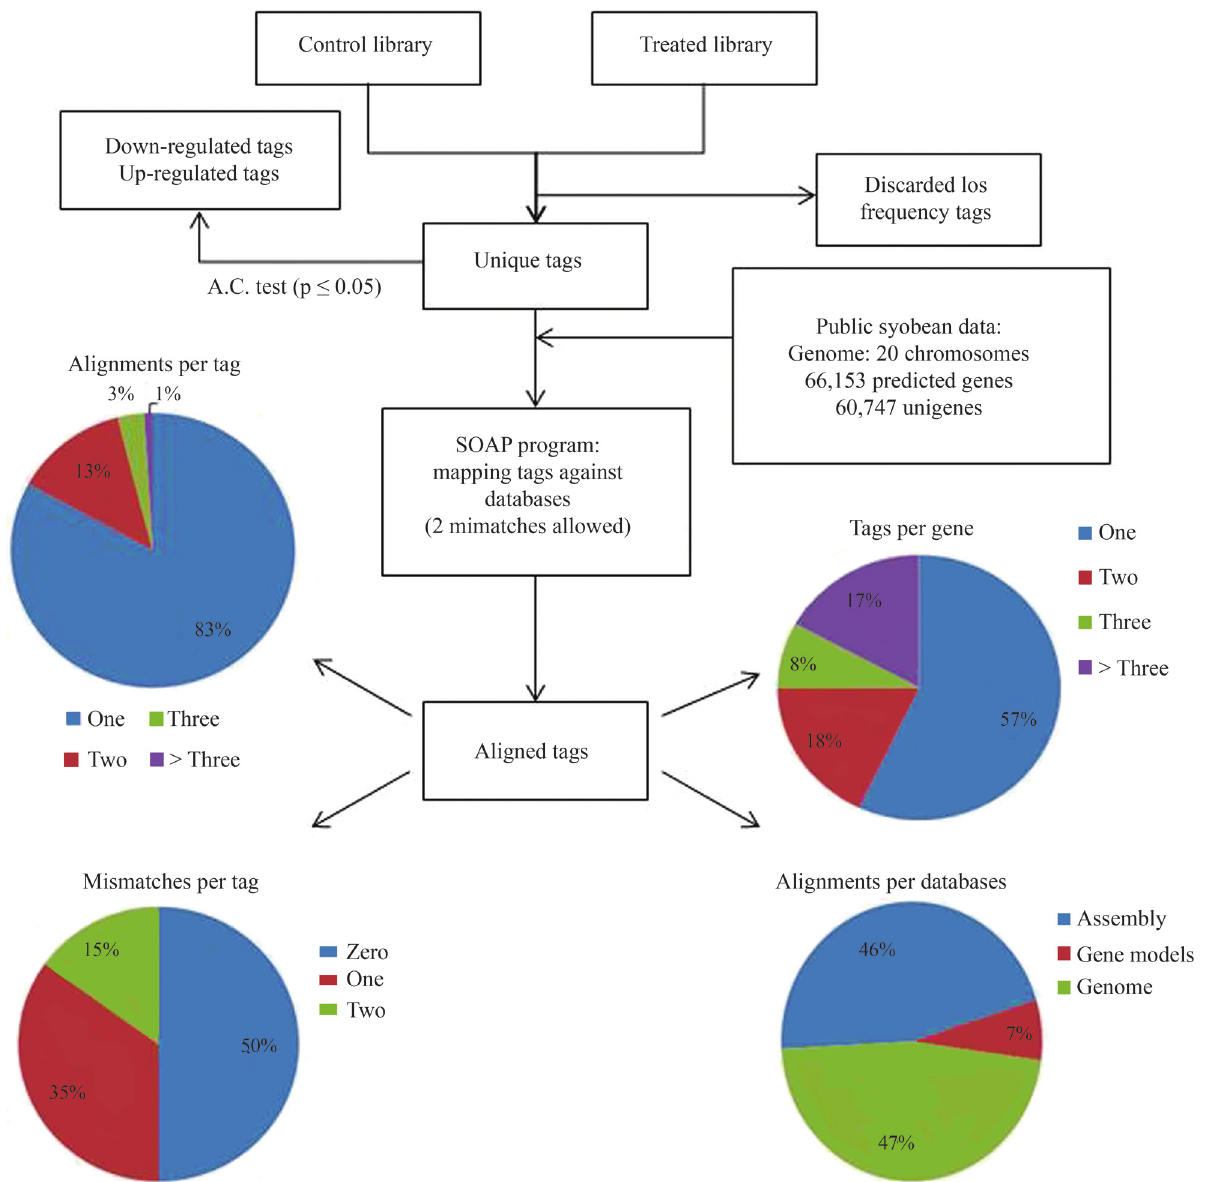
Figure 3 - Complete pipeline of the SuperSAGE data analysis. All tags (control and treated libraries) of each sample were grouped in unique tags. The unique tags were aligned against the public soybean databases using the SOAP2 aligner. Most of the tags have one alignment (83%) and up to one mis - match (85%). A summary of the total, unique, mapped and differential tags is shown in Table